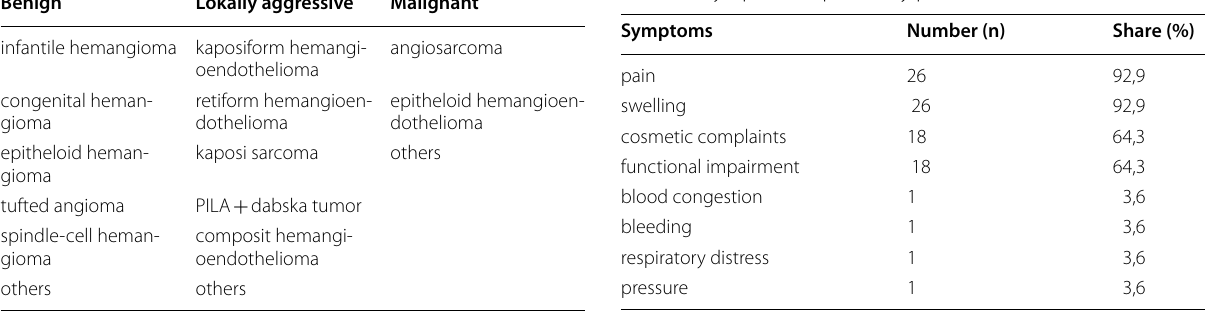
Table 7 Symptoms reported by patients with